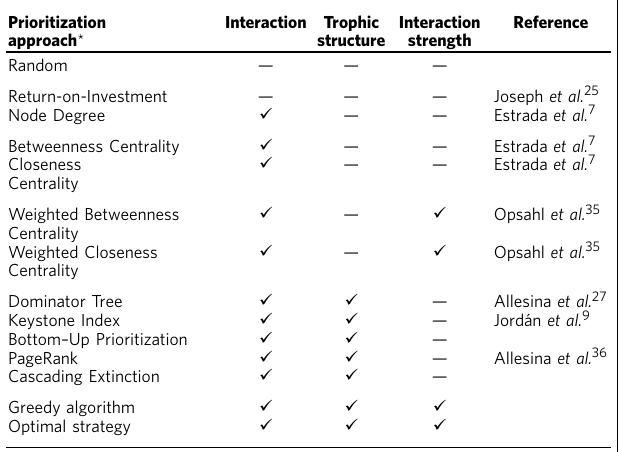
*Groupings represent classes of indices based on the degree and type of complexity